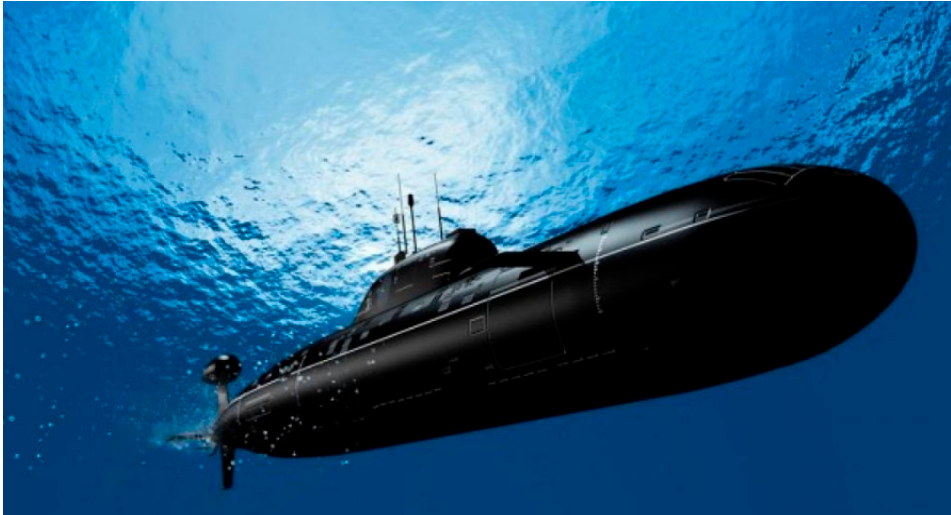
Figure 1. One of the most formidable means of destruction in the world are submarines. They are not only ideally suitable for covert operations and intelligence and diversionary operations against the enemy, but they are also capable of carrying nuclear armament and exercising extreme pressure on the enemy’s defensive redoubts.